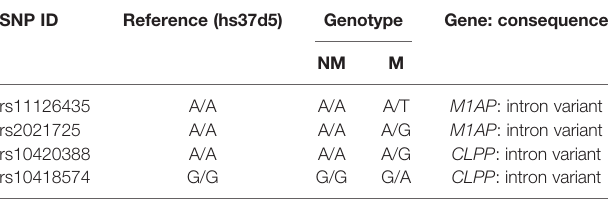
TABLE 2 | SNPs that differentiate between groups.